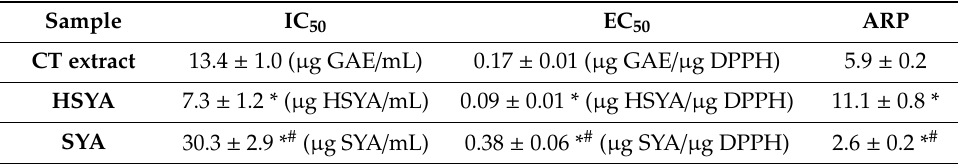
Table 2. Comparison of values of antiradical activity evaluated by 2-diphenyl-1-picrylhydrazyl (DPPH) of Carthamus Tinctorius (CT) extracts, hydroxy sa ffl or yellow A (HSYA) and sa ffl or yellow A (SYA): IC 50 , EC 50 , and antiradical power (ARP). * p < 0.05 vs. CT extract; # p < 0.05 vs. HSYA.